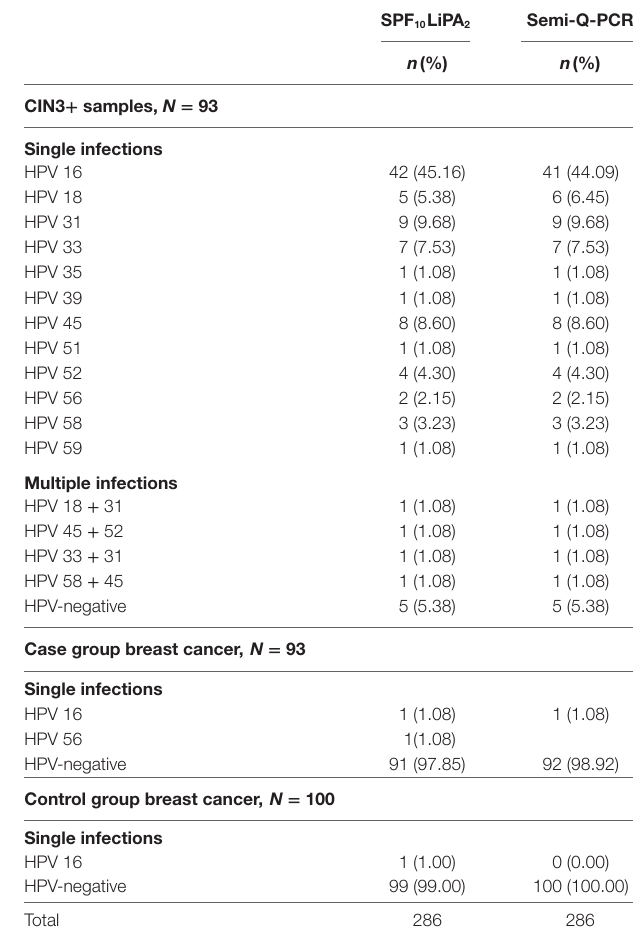
TaBle 4 | Human papillomavirus (HPV) genotype distribution in breast cancer and CIN3 +